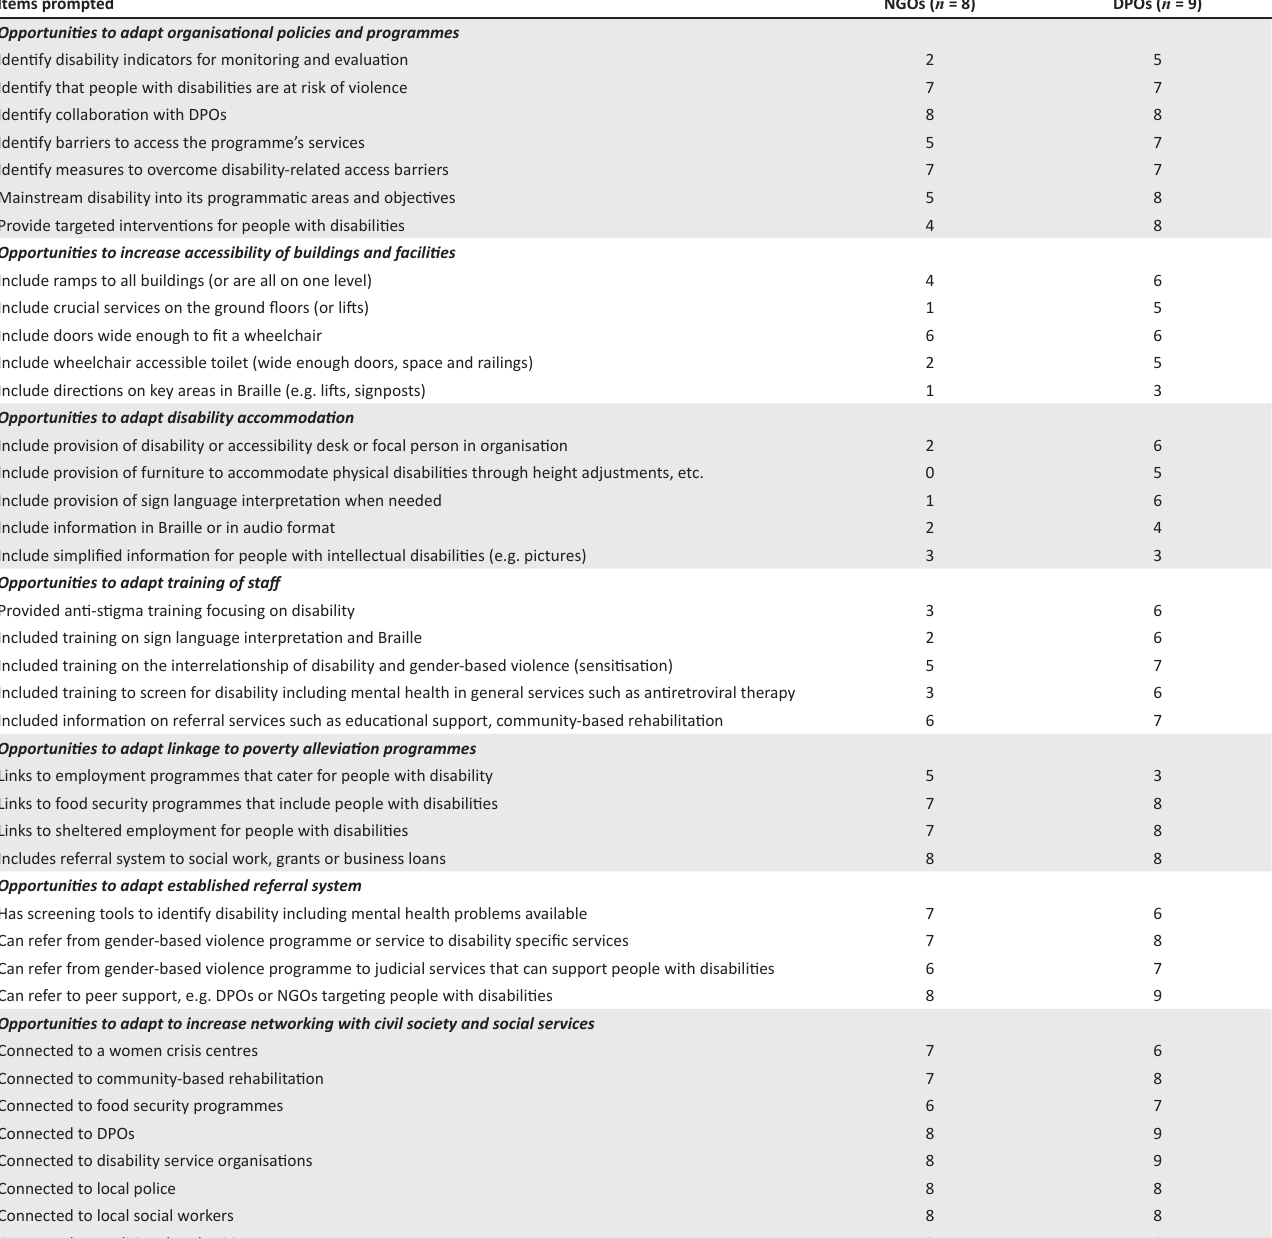
TABLE 3: Identified organisational opportunities for change. Items